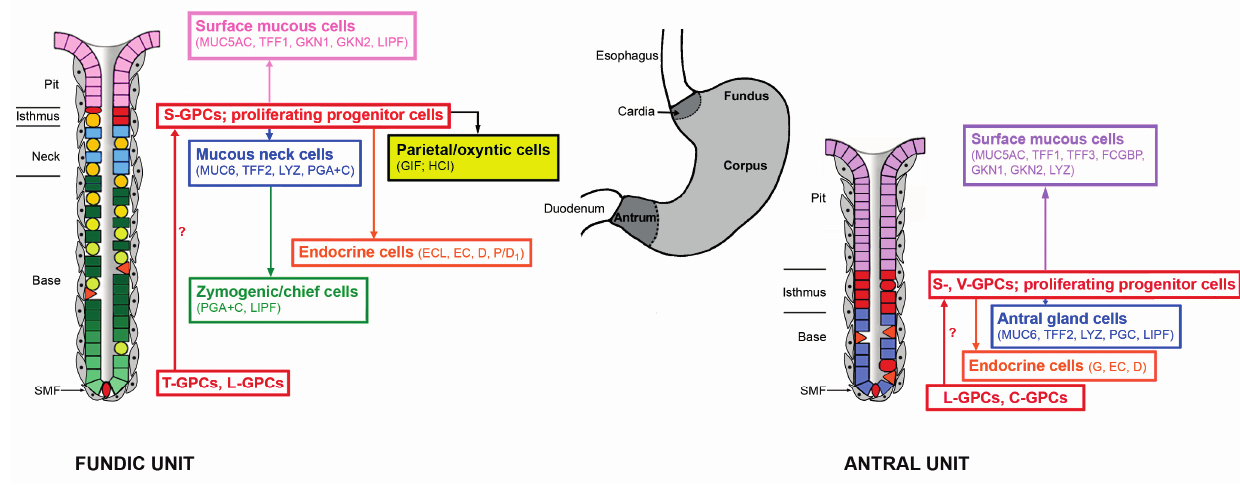
Figure 1. Schematic representation of the two gross types of human gastric units and their continual, bidirectional self-renewal from gastric progenitor cells (GPCs)/stem cells. Shown are the major epithelial cell types and some of their characteristic secretory products such as MUC, mucins; TFF peptides, FCGBP, IgG Fc binding protein; GKN, gastrokines; LYZ, lysozyme; LIPF, gastric lipase, PGA and PGC, pepsinogens; GIF, intrinsic factor; and HCl, hydrochloric acid; as observed in the classical fundic and antral units, respectively. The various gastric precursor cell (GPCs)/stem cell populations are marked in red: C, CCK2 receptor + ; L, Lgr5 + ; S, Sox2 + ; T, Troy + ; V, villin + ; EC(L), enterochromaffin(-like); G, gastrin; SMF, subepithelial myofibroblast; (modified and updated from